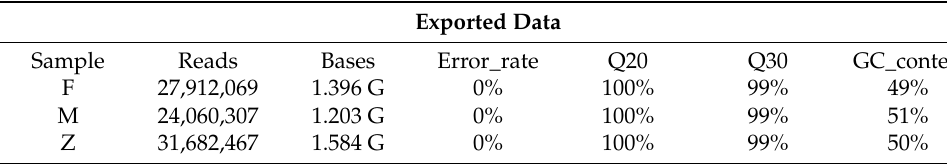
Table 2. Data output statistics of three samples (F, M, Z).